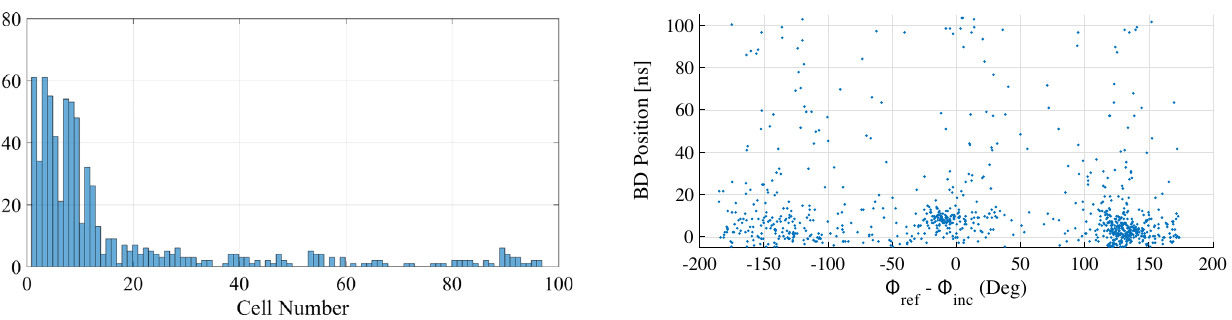
FIG. 32. Spatial distribution of breakdowns along the structure showing the number of breakdowns accumulated by each cell.